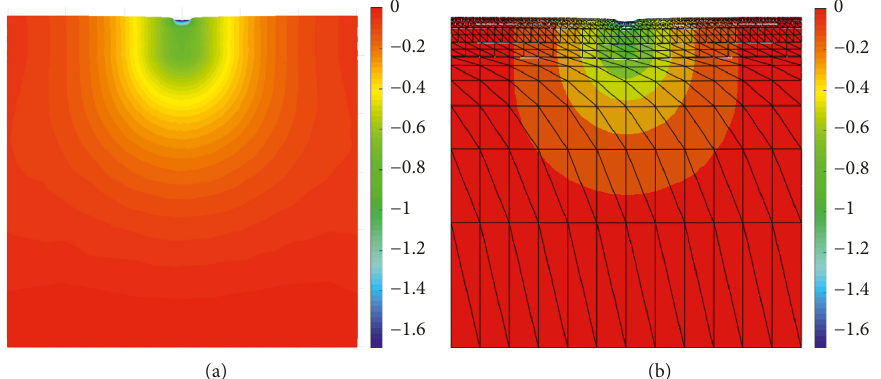
Figure 7: The computational vertical displacement from (a) SAFEM and (b) ABAQUS with a scale factor of 50 in static analysis with linear viscoelastic material property.